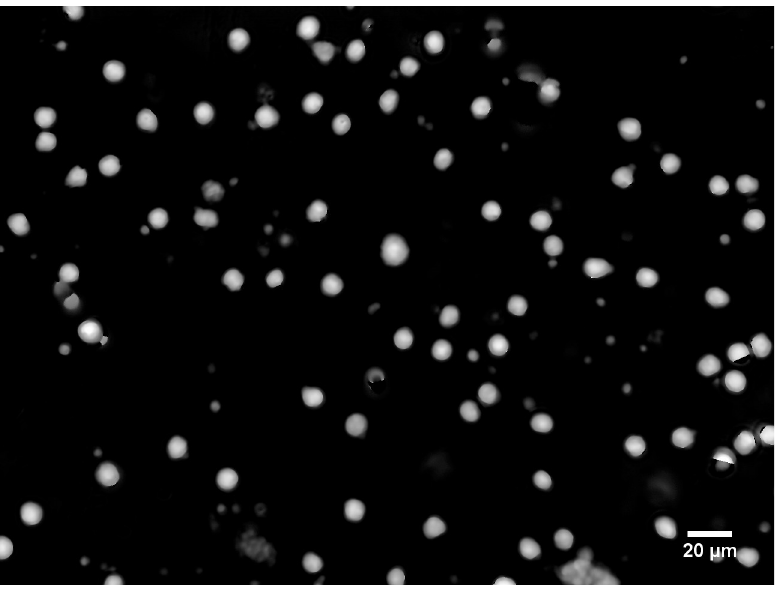
Fig 2. Full-field of view of a QPM image of WBCs after the removal of curvature in phase. White spots are QPM images of single WBCs, and the black region is background. Image size is 350 × 260 μ m (1292 × 964 pixels). In the sample preparation, only WBCs were extracted from whole blood and then suspended in